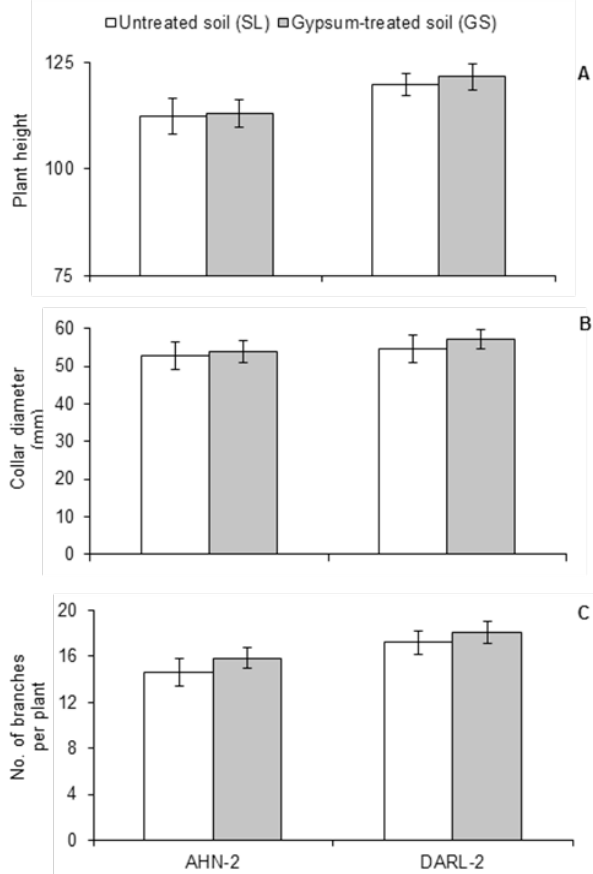
Fig. 2. Growth performance of plants of elite strain (DARL-2) and local strain (AHN-2) of J. curcas after two years of field transplantation: Plant height (A); Collar diameter (B); Number of branches/plant (C). Seedlings of both the strains were grown on untreated and gypsum-treated soils. Vertical bars represent ± S.E. of